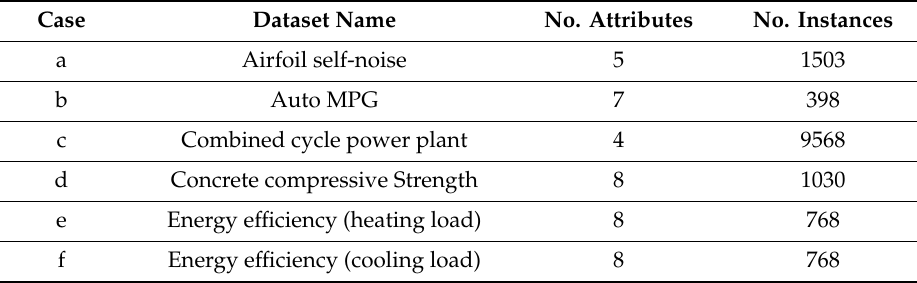
Table 1. List of the selected UCI machine learning datasets and their